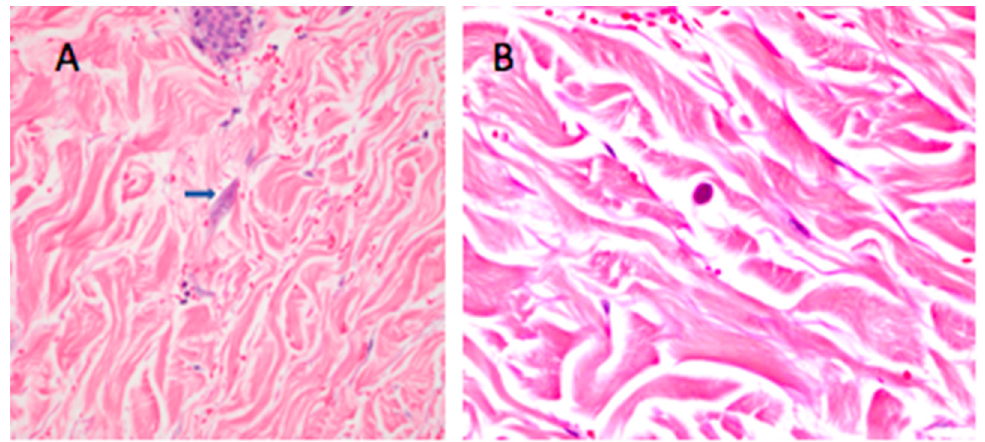
Figure 4. Case 1. ( A ) Longitudinal section of infective filariform Strongyloides stercoralis within subcutaneous tissue in skin biopsy of abdominal wall, stained with H&E. Image taken at 200× magnification. Note the absence of inflammatory cells [12]. ( B ) Cross section of infective filariform Strongyloides stercoralis within subcutaneous tissue in skin biopsy of abdominal wall, stained with H&E. Image taken at 400× magnification.